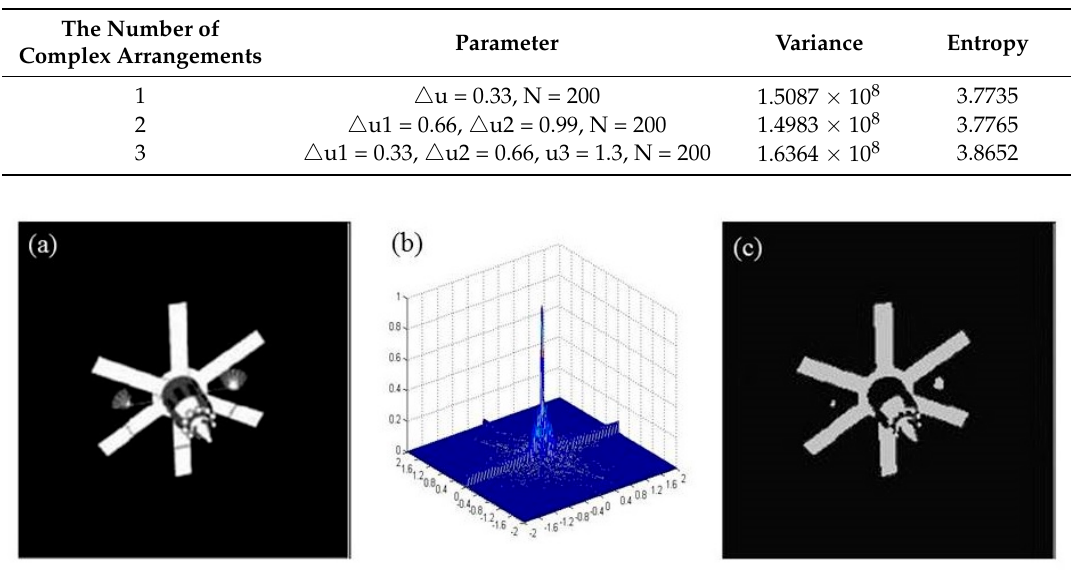
Figure 8. ( a ) Light intensity distribution of the source; ( b ) mutual intensity spectrum detected with the rectangular arrangement ( △ u = 0.33, N = 200); ( c ) actual imaging of the system.